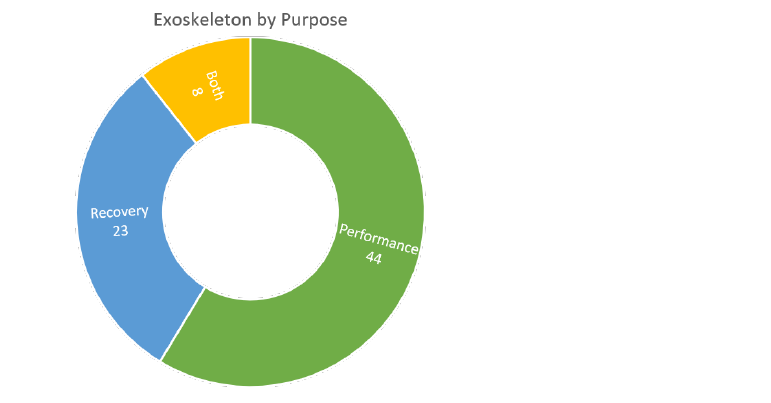
Figure 9. This chart portrays the classification of exoskeletons according to their purposes. More than half of all the exoskeletons reviewed were used for performance, specifically 59%. On the other hand, 31% of all the exoskeletons were used for recovery, and the exoskeletons having both purposes only encompassed 11% of the exoskeletons reviewed, as seen in Figure 9. Recovery exoskeletons are focused on specific pathologies, making them harder to produce than performance exoskeletons that have some more general use.